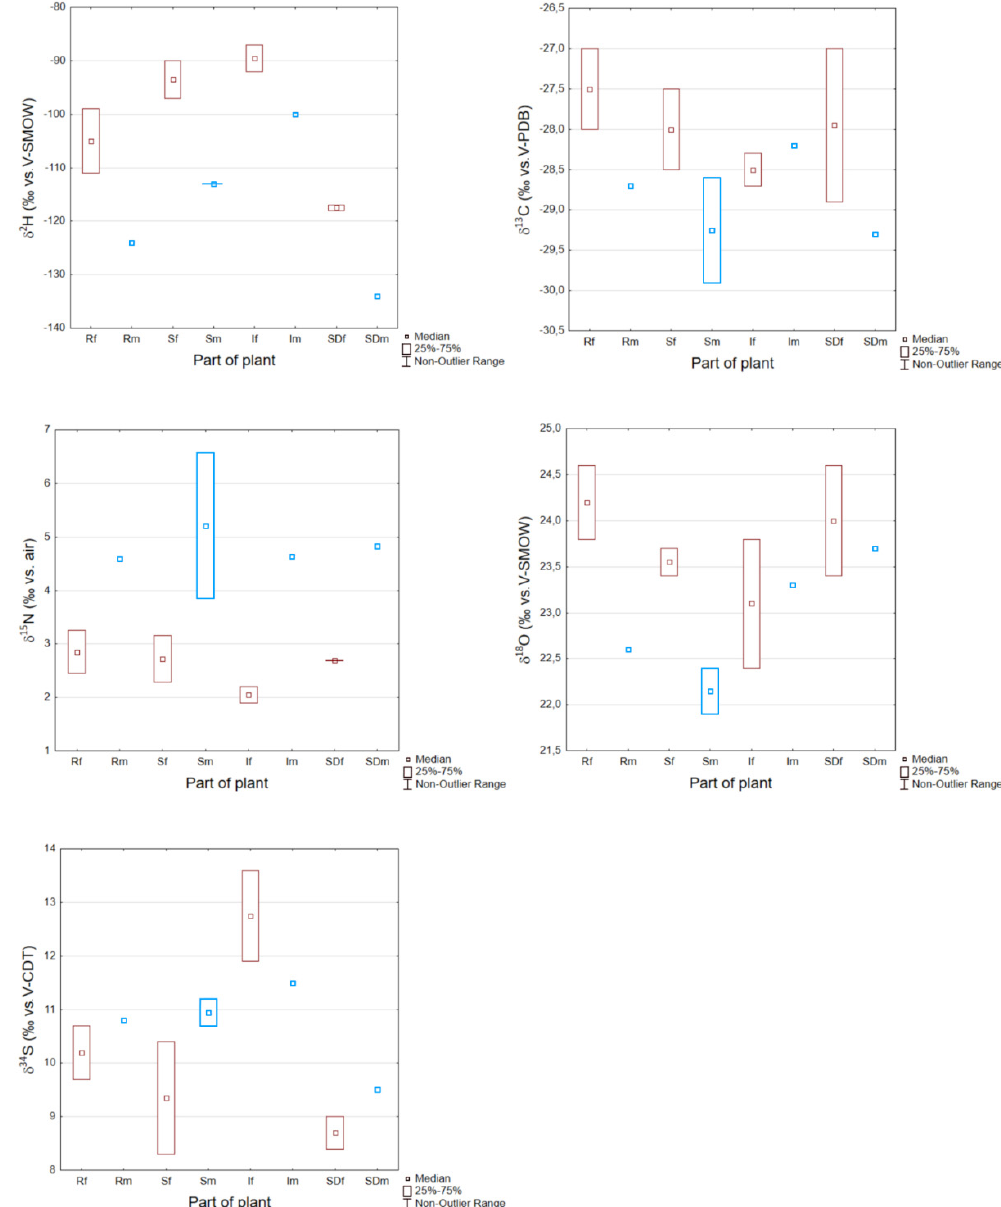
Figure 4. Box-plots of δ 2 H, δ 13 C, δ 15 N, δ 18 O, and δ 34 S values, expressed in ‰, of Italian industrial hemp samples ( Cannabis sativa L.) collected at the Udine sampling site in Friuli Venezia Giulia region (NE Italy), ordered according to the part of plant and the fertilization strategy (conventional in red, organic in blue). V-SMOW = Vienna-Standard Mean Ocean Water, V-PDB = Vienna-Pee Dee Belemnite, V-CDT = Vienna-Canyon Diablo Troilite, R = Roots, S = Stems, I = Inflorescences, SD = Seeds, f = grown under synthetic fertilization, m = grown under bovine manure fertilization. Moving from the roots to the inflorescences, increasing mean δ 2 H values were ob- served, while a pronounced depletion was registered for the δ 2 H values in the inflorescences compared to the seeds (mean decrease of 32%; Table 1), likely due to the lower cellulose content and a higher content of lipids in seeds [39]. This pattern was observed in both